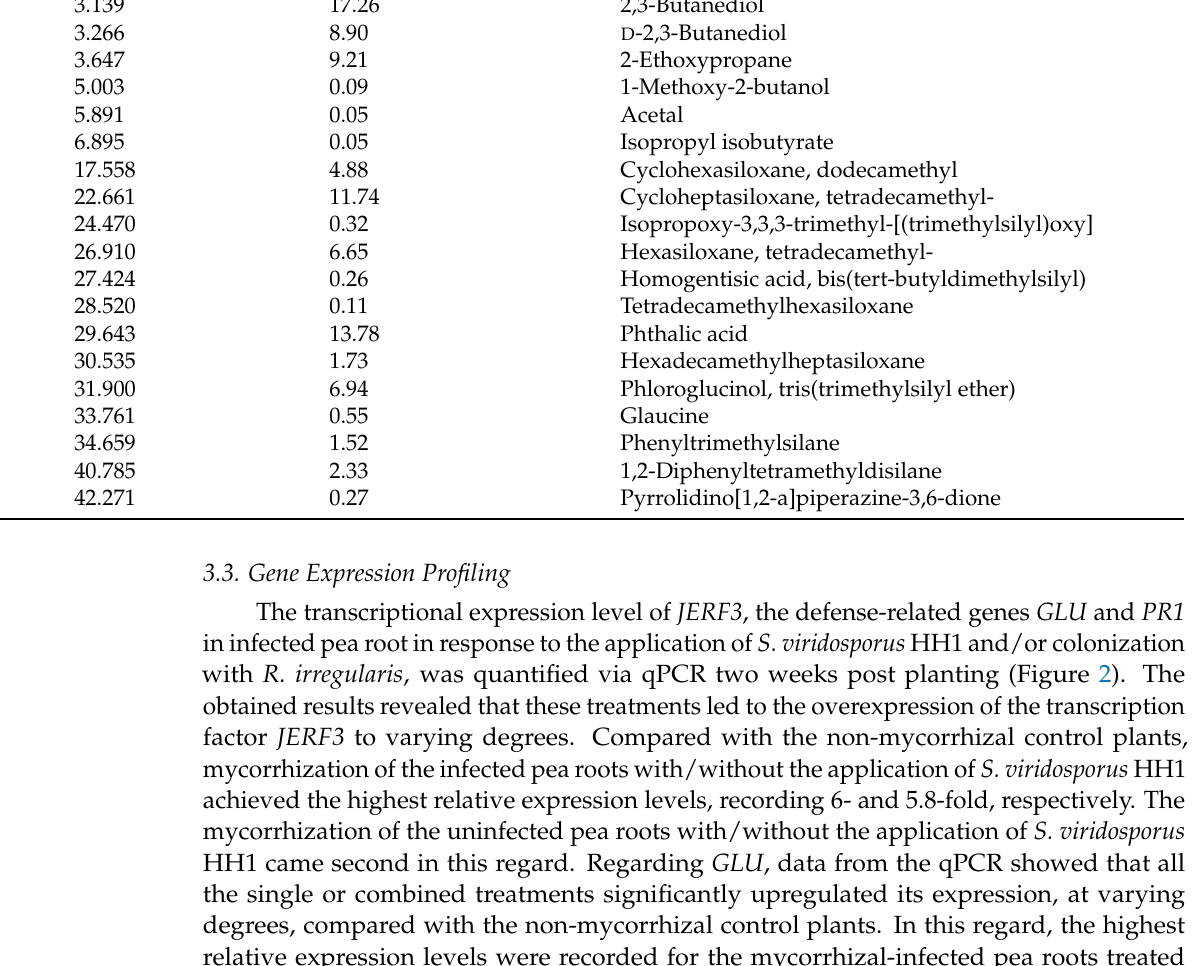
Table 2. Secondary metabolites produced by S. viridosporus HH1 identified using GC-MS system.